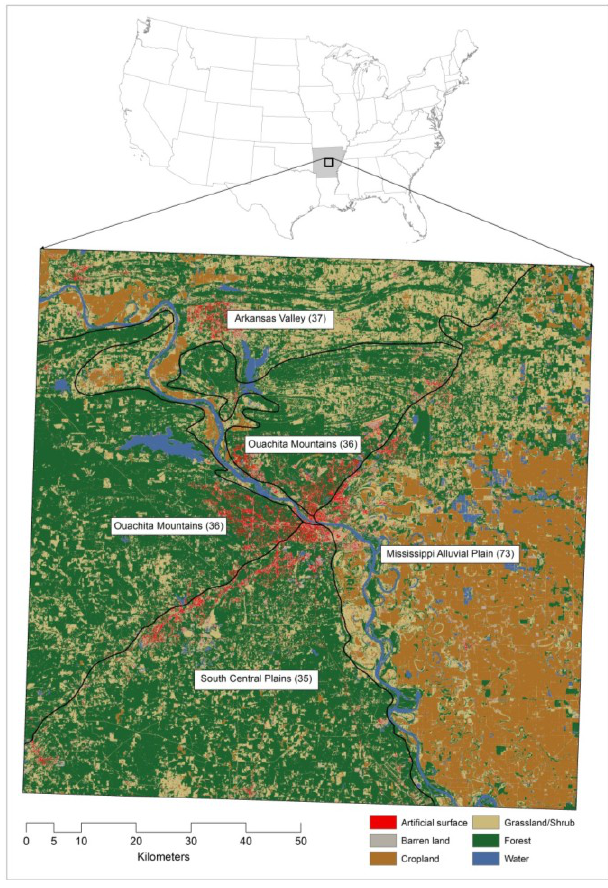
Figure 1. The study area centered on Little Rock, Arkansas, USA. The base layer is the land cover map (2010; 30-meter resolution) generated by the per-pixel classification in this study. The four Omernik Level III ecoregions are outlined in